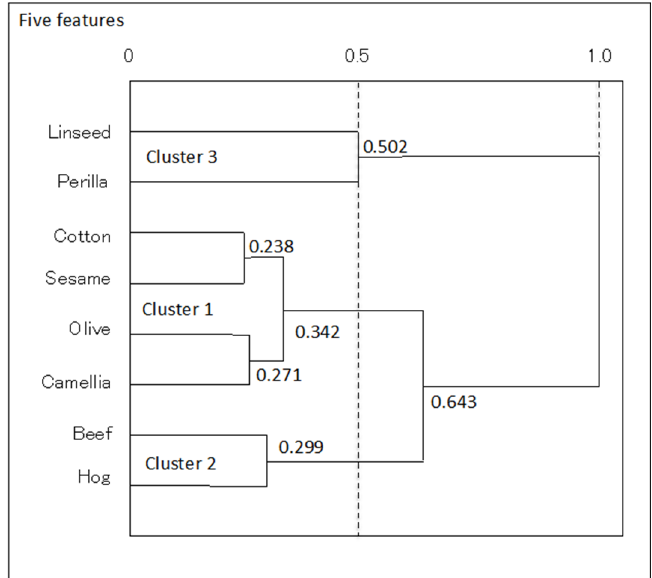
Figure 10. Dendrogram using HCC for five features. Table 6. Average compactness of each feature in each clustering step.